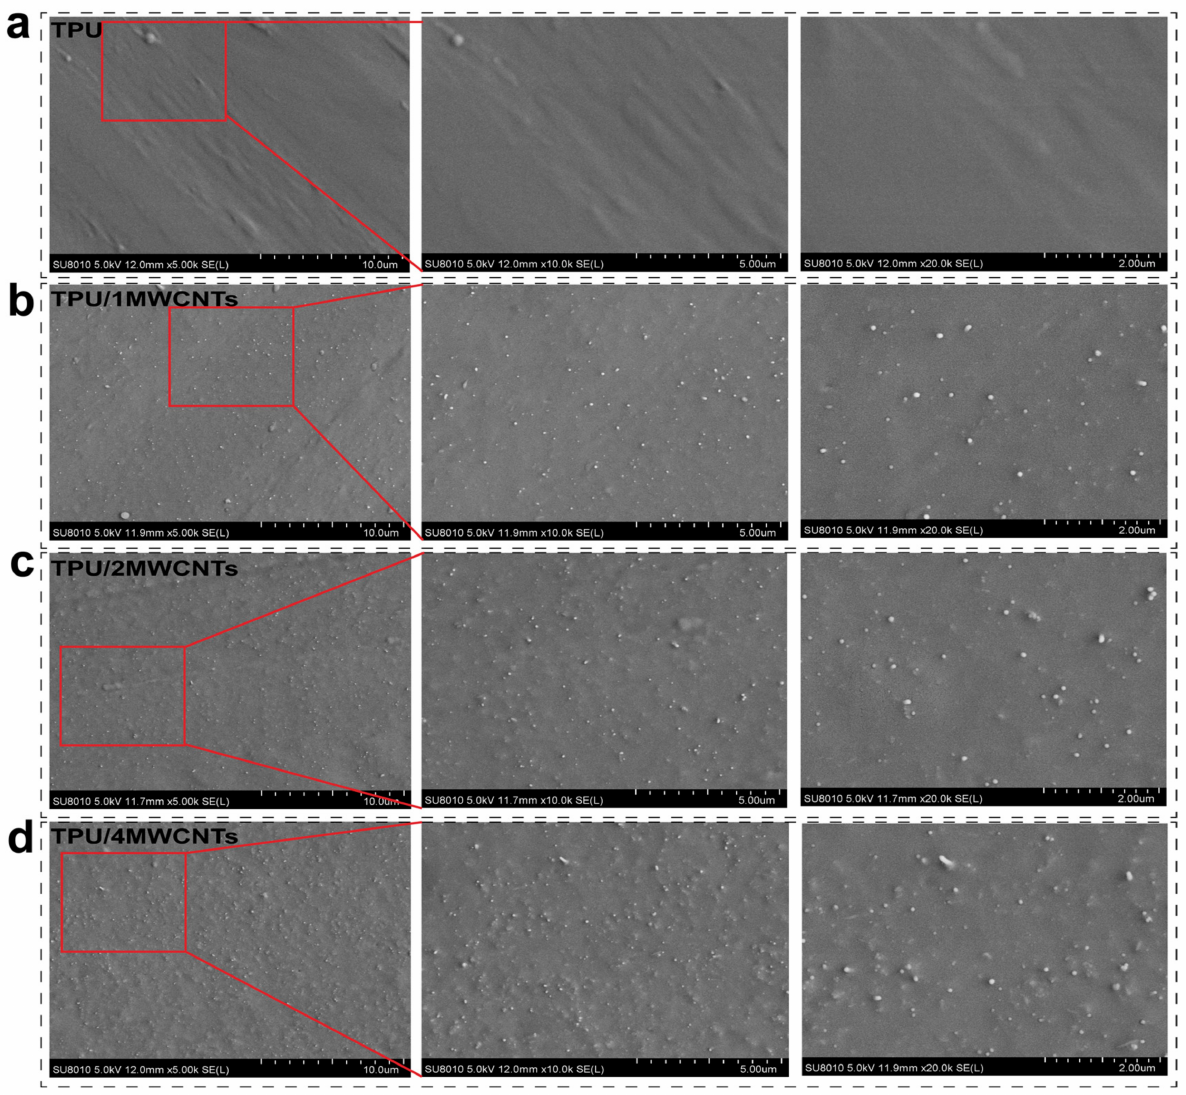
Figure 1. ( a – d ) Microscopic morphology of TPU and TPU/MWCNTs filaments with different MWC- NTs content (0, 1, 2, 4 wt%). (Magnification: 5k, 10k,